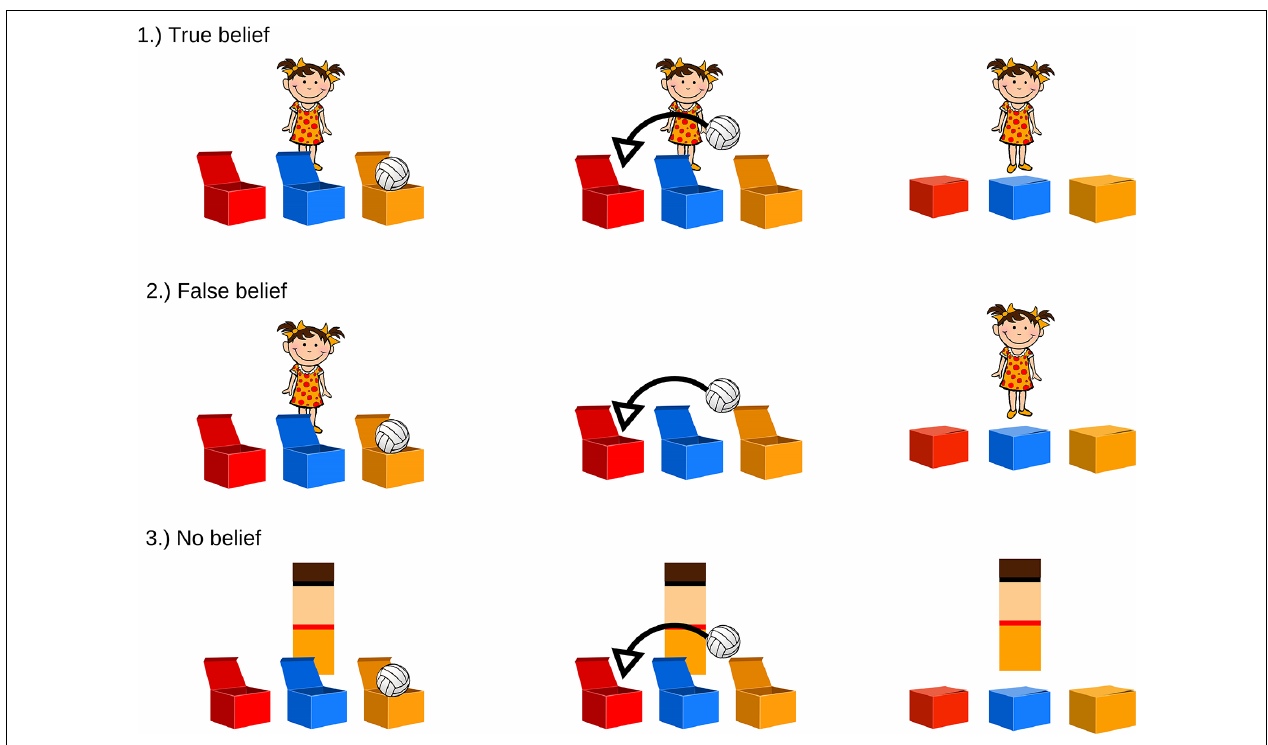
FIGURE 1 | Examples of theory of mind (ToM) tasks. Each participant watched four cartoons of each condition. (1) True-belief (TB) and (2) false-belief (FB) conditions differed in the presence of the character while the toy changed location. In the (3) no-belief (NB) condition, the character was replaced with a color-matched geometrical